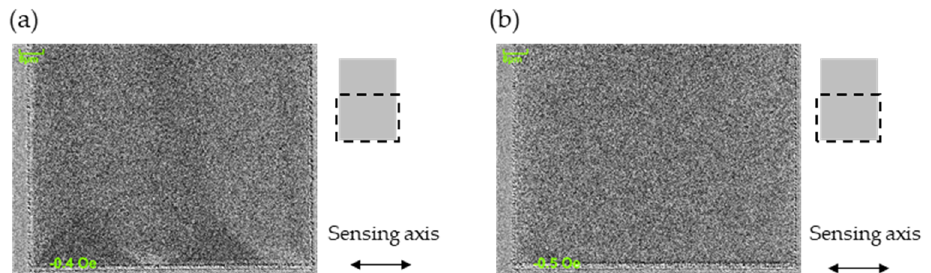
Figure A1. ( a – c ) Cross-sectional STEM image of TMR multilayers. The stacking structure of ( a , b ) is Sub. Si, SiO 2 /Ta 5/Ru 20/Ta 5/ free-layer 130/Ru 0.9/Co 40 Fe 40 B 20 3/MgO/Co 40 Fe 40 B 20 3/Ru 0.85/Co 75 Fe 25 2/ Ir 22 Mn 78 10/ Ta 5 / Ru 10 in nm. The table shows the configuration of the sputtering system and the material of the free layer. ( d , e ) Average surface roughness, R a , dependence of magnetic and electronic noises, respectively. The longitudinal error bars show the difference between the maxi- mum or minimum values and the average value in three samples prepared in the same condition. The transverse error bars show the empirical measurement errors.